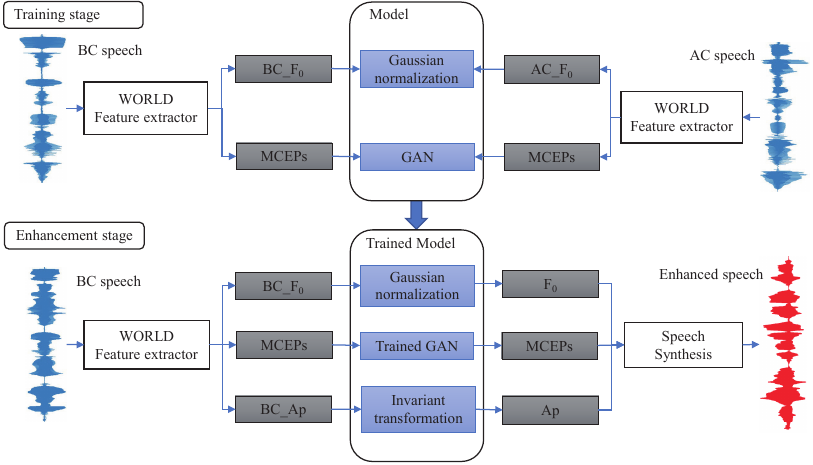
Figure 1. Architecture of the proposed BSEGAN-SI method.